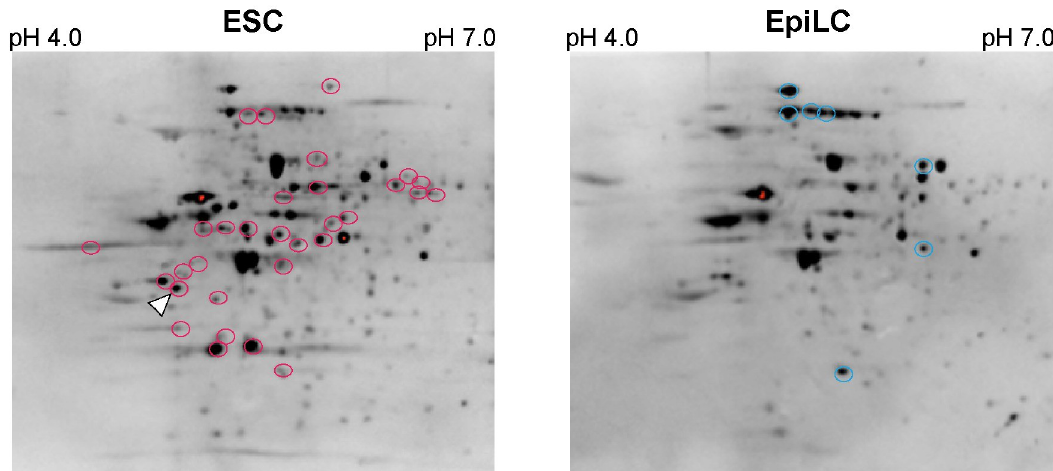
Fig 4. Detection of O-GlcNAcylated proteins from ESC or EpiLC using disaccharide-method. Increased spots in ESCs are indicated in red circles and increased spots in EpiLCs are indicated in blue circles. The spot of Sox2 is shown in white arrowhead in